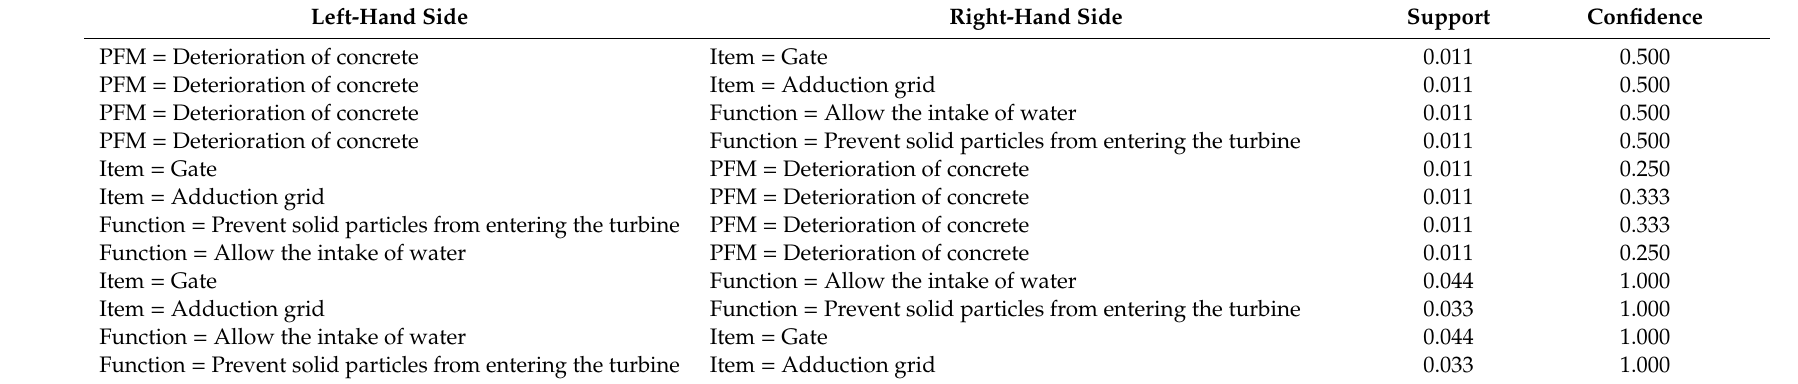
Table 3. Excerpt of the ARs among the PFM, item of the portion of the network reported in Figure